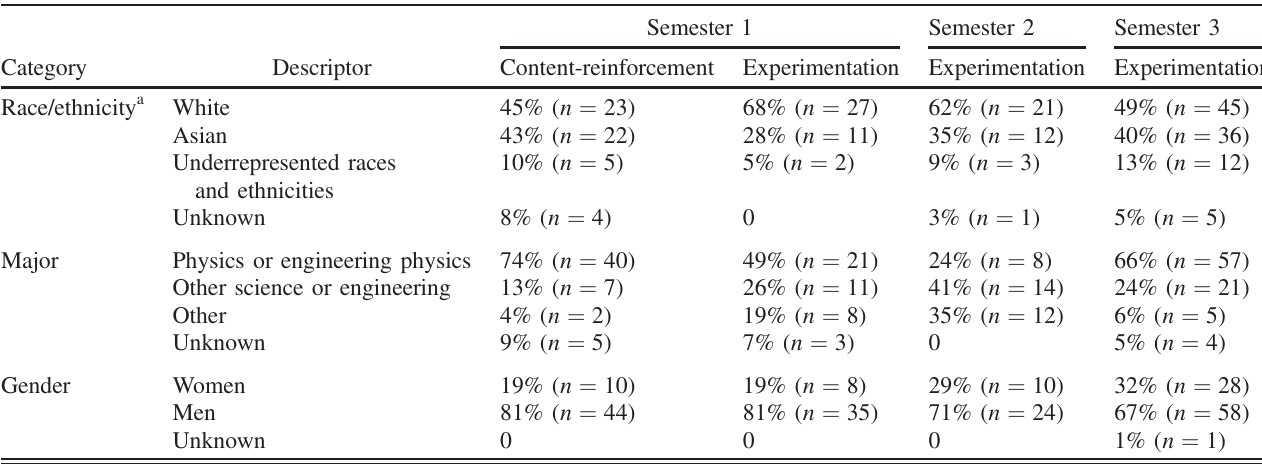
TABLE II. Student demographics in the different conditions and semesters. Students self-reported their demographic information on an end-of-semester survey, but not all students answered all demographic questions. Several additional descriptors for all categories are included on the survey (e.g., additional options for gender). The underrepresented races and ethnicities category is defined relative to the physics